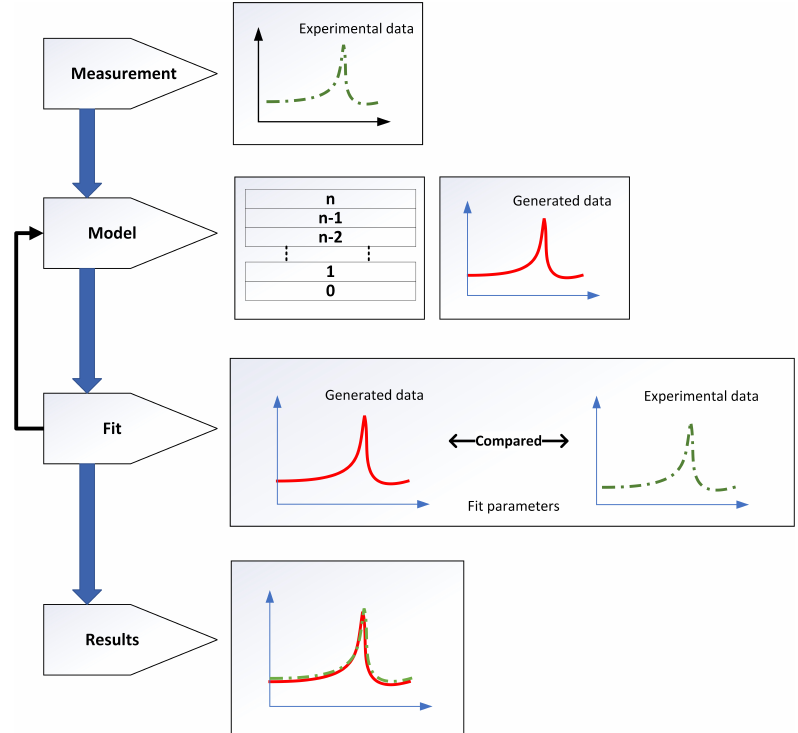
Figure 7. Flow chart for ellipsometry data